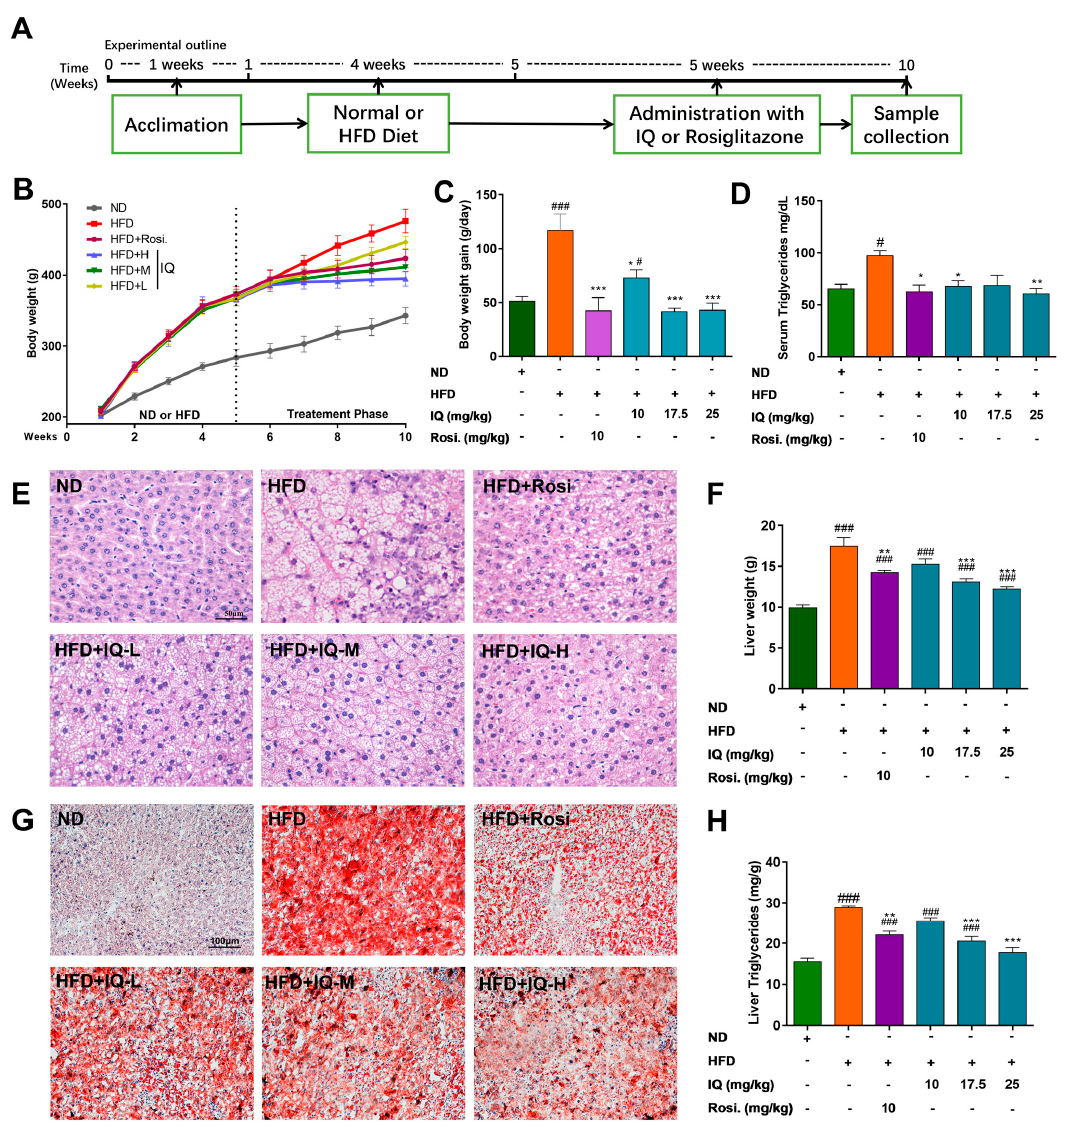
Figure 1. Isoquercetin (IQ) improves the condition of high-fat diet (HFD)-induced nonalcoholic fatty liver disease (NAFLD) rats by decreasing body weight and lipid accumulation. ( A ) The timelines and intragastrical administration schedule of various compounds used in the study; ( B ) the body weight curves of different groups used in the study; ( C ) the body weight gain/day during treatment intervention; ( D ) the serum triglyceride (TG); ( E ) demonstrated the haematoxylin and eosin stain (H&E) of the liver; ( F ) demonstrated the liver weight; ( G ) demonstrated the oil red stain of the liver; ( H ) illustrated the liver TG. The data represents ± SD. p < 0.05 was considered as statistically significant. # p < 0.05, ### p < 0.001 represent compared with normal diet (ND) group. * p < 0.05, ** p < 0.01, *** p < 0.001 represent compared with HFD group. The significant statistical difference as calculated by one-way ANOVA with Tukey’s post hoc test. ( n = 6 each group).